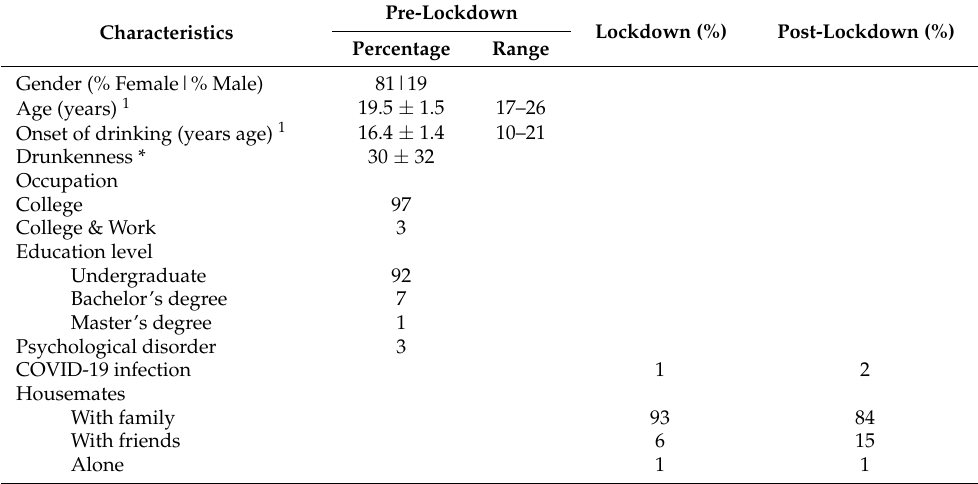
Table 1. Socio-demographic and lifestyle characteristics of the